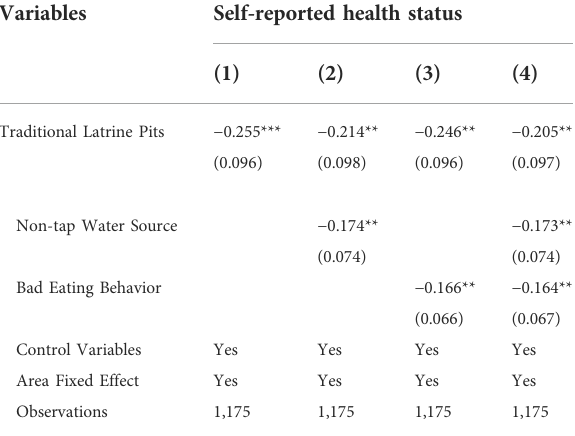
TABLE 6 Mechanism: Water pollution and Fecal-oral